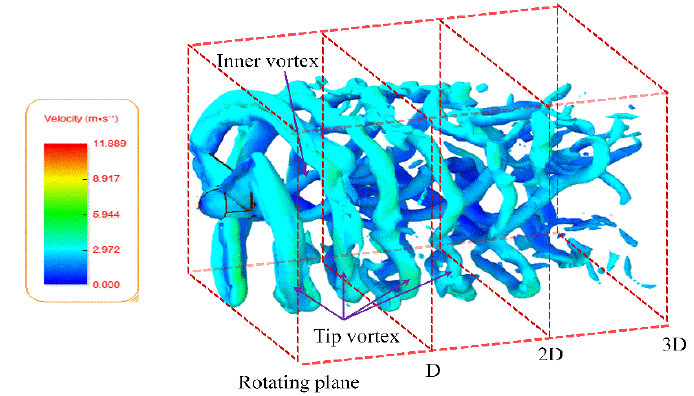
Figure 9. Instantaneous view of vortex structures in the flow field.